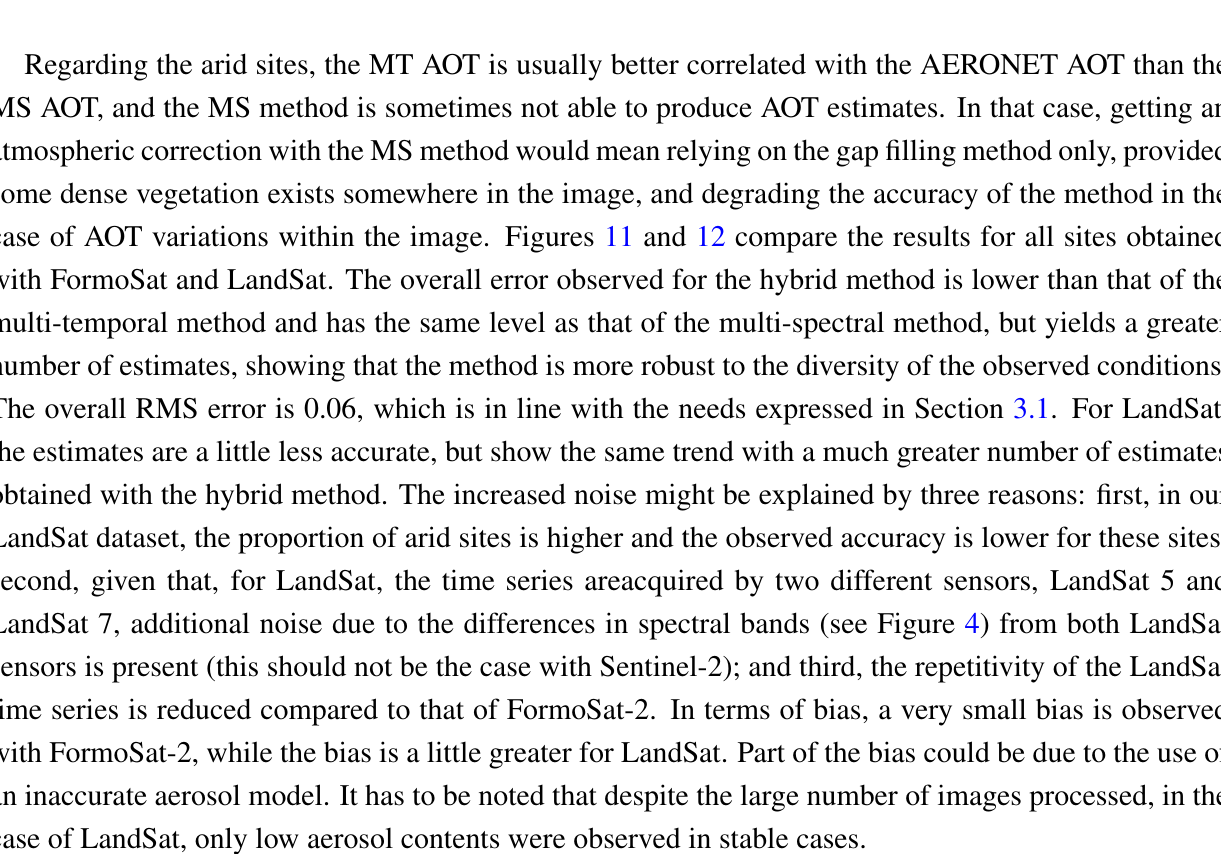
Figure 10. Comparison of AOT estimates at 550 nm obtained from hybrid ( left ), MS ( middle ) and MT ( right ) methods for two LandSat sites: Columbia (top) and Fresno (bottom). Blue circles correspond to stable conditions and red triangles to unstable